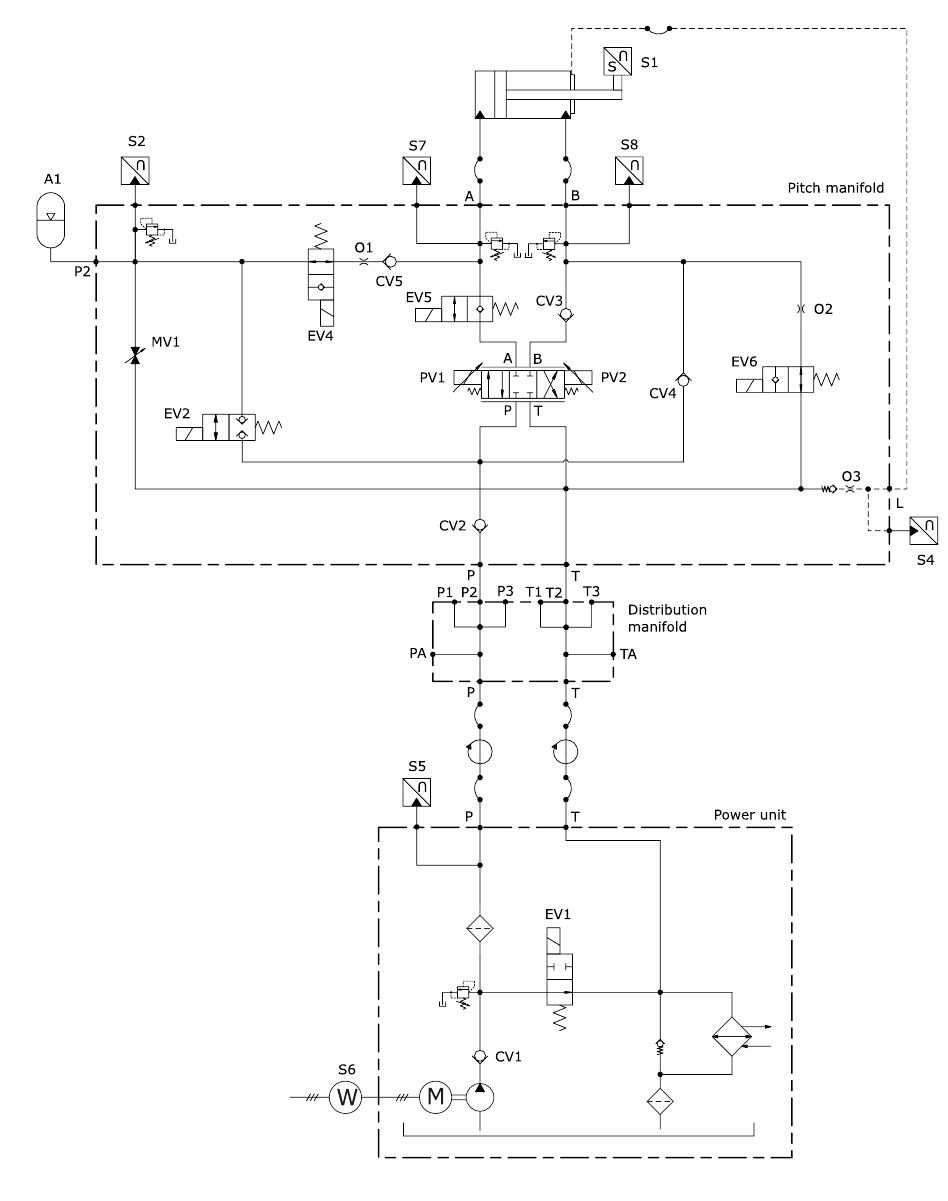
Figure 1. Reference hydraulic